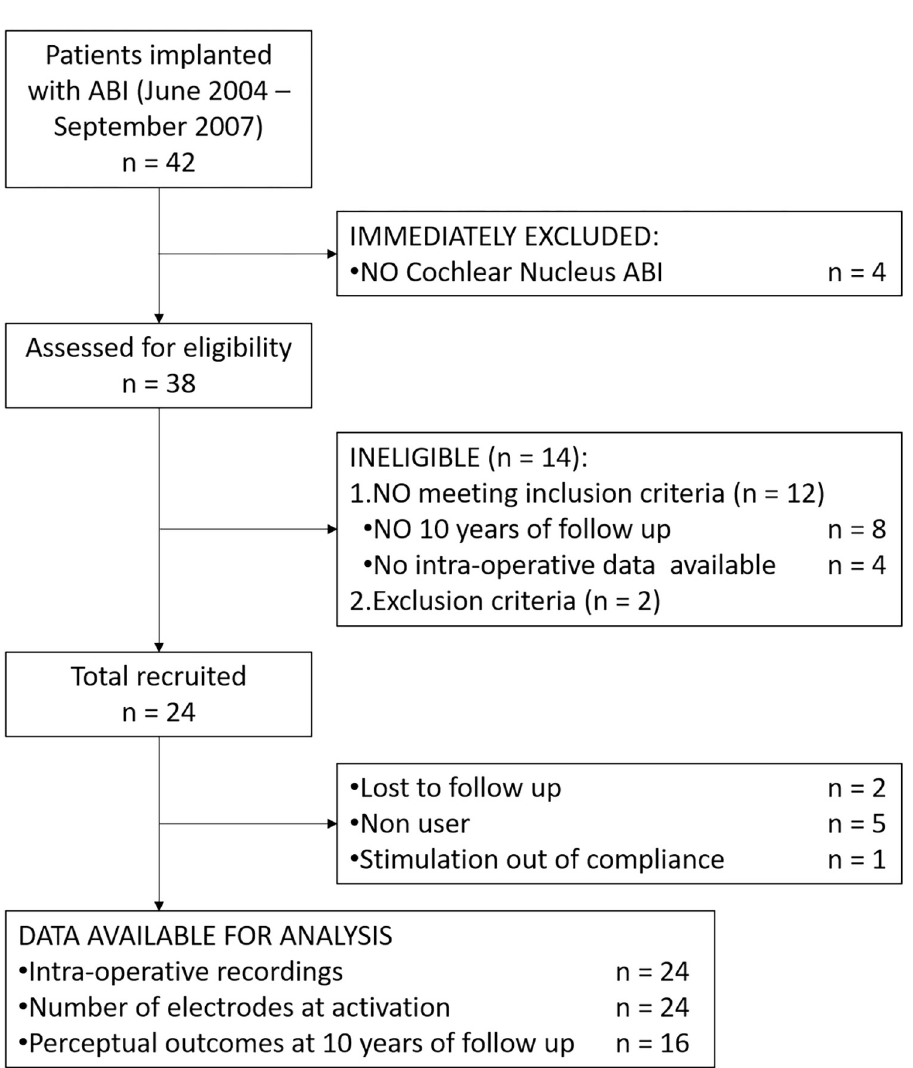
Fig 1. STROBE flow diagram of patient selection. between CP and MP in terms of the mean number of viable electrodes from EABRs. For the patients where both protocols were used to record EABRs (AD9, AD10, AD11, AD13, AD15, AD16, CH7), a paired t-test showed no significant different in EABRs between the two proto- cols [t(6) = -0.2, p = 0.850]. However, the number of viable electrodes from EABRs (mean = 18.9 ± 2.5) greatly overestimated the number of electrodes in the clinical map (mean = 13.5 ± 4.6. A paired t-test was performed on the electrode data to compare the number of viable electrodes from EABRs to the number of active electrodes in the clinical map; EABR data were averaged across the protocols for the patients in whom both CP and MP were used. The number of viable electrodes from EABRs was significantly higher than the number of active electrodes in the clinical map [t(30) = 6.9, p < 0.001]. The difference between the num- ber of viable electrodes from EABRs and active electrodes in the clinical map was � 2 in 20.8% of patients, > 2 � 4 in 16.7% of patients, > 4 � 6 in 16.7% of patients, and > 6 in 45.8% of patients.